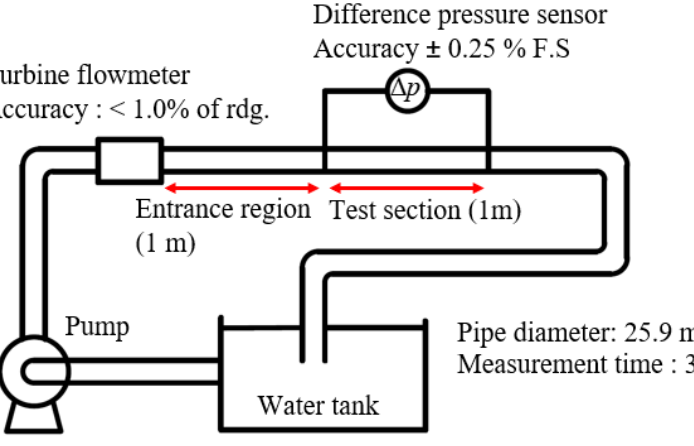
Figure 5. The experimental Figure 5 . The experimental appartus .